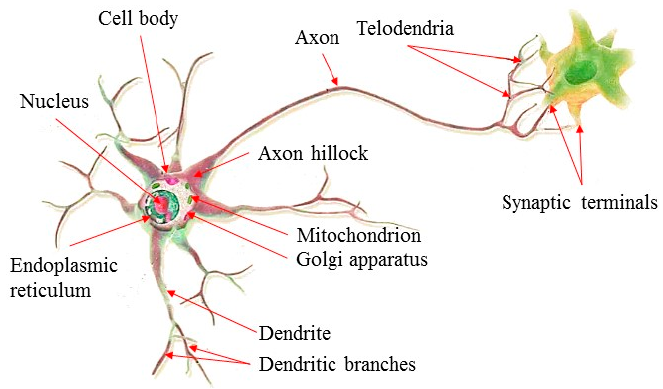
Figure 14. Schematic diagram of biological neuron structure.